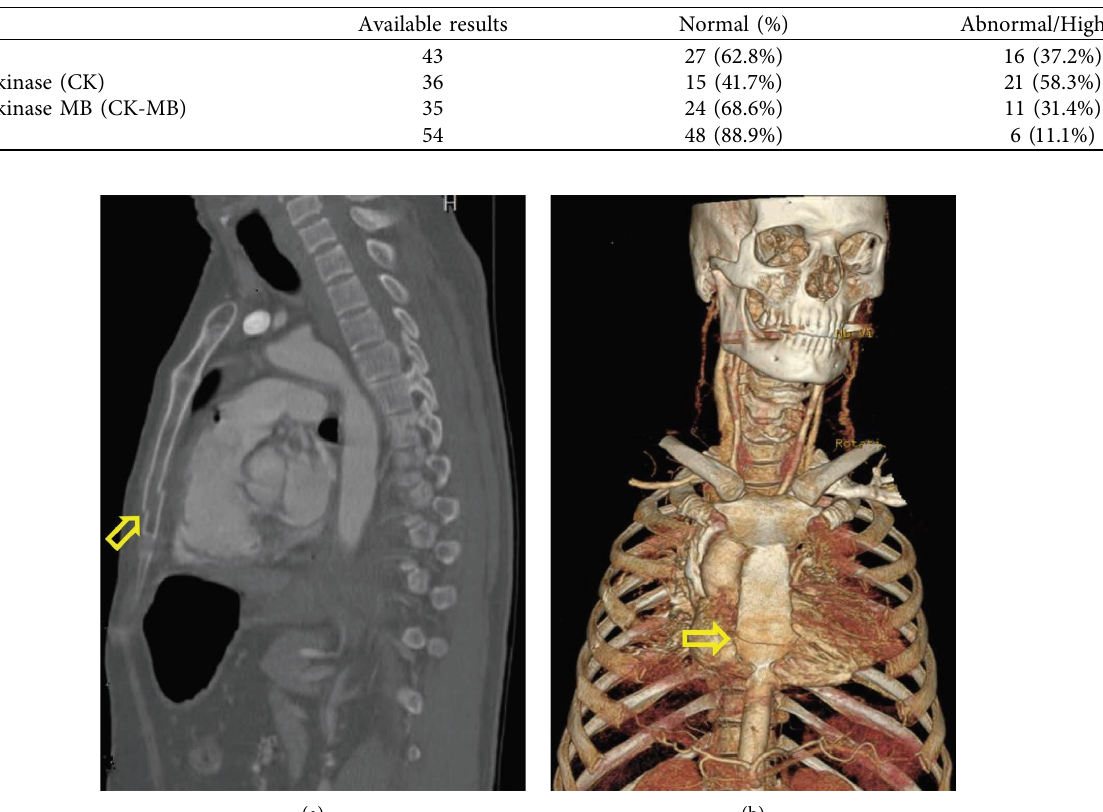
Figure 1: A 56-year-old male truck driver involved in a motor vehicle collision. He had multiple lower limb fractures, hemothorax, multiple fractured ribs, and hypotension. He had an abnormal ECG and an elevated troponin level at the time of his presentation to the emergency department. He was admitted to the ICU and died on day 5 after admission. Computed tomography (CT) scan showing (a) sagittal reformat with displaced fracture of the body of the lower part of the sternum (yellow arrow), which was initially missed on axial slices; (b) 3-dimensional model showing fracture of the body of the sternum (yellow